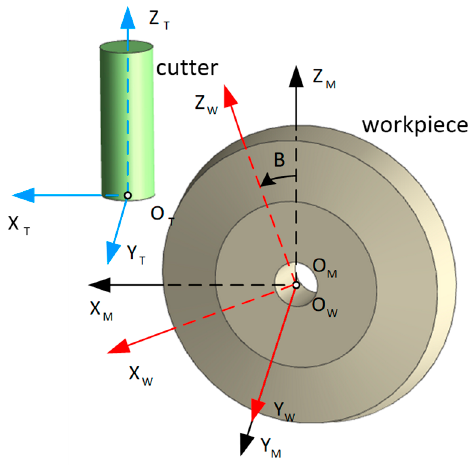
Figure 2. Three coordinate systems are defined.